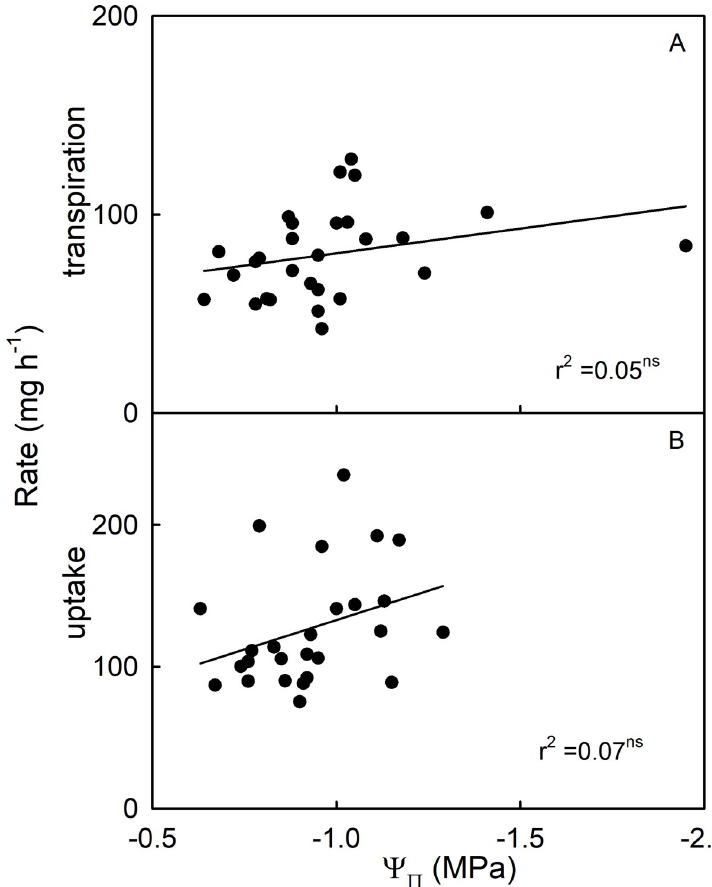
Fig 4. Relationship between osmotic potential ( C P ) of a strawberry fruit’s expressed juice and water movement. (A) Rates of transpiration and (B) Rate of osmotic water uptake. Coefficients of determination (r 2 ) not significant at P <